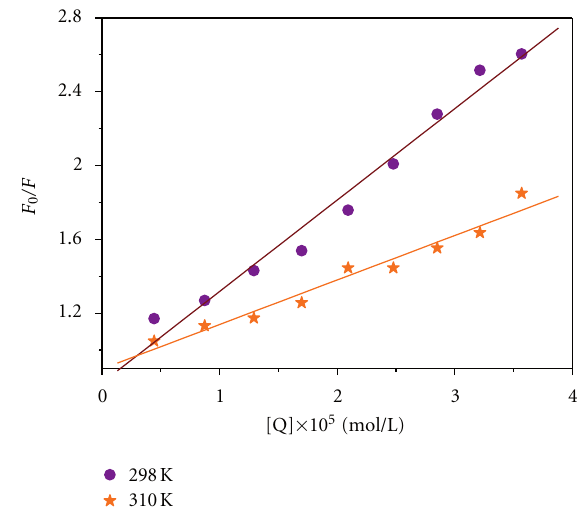
F 4: Sterne-Volmer plot of the �uorescence quenching of BSA with various amounts of Evo at 298K (•) and 310K (